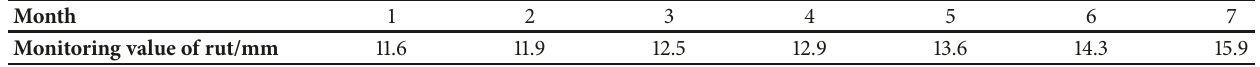
Table 5: The monitoring value of average rut for prediction.